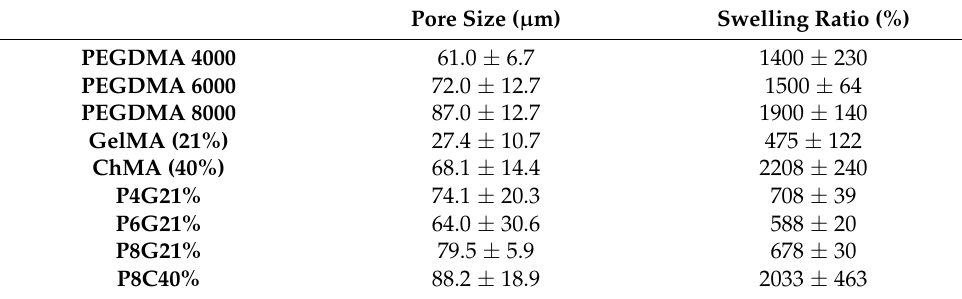
Table 2. Comparison of morphology and swelling behavior for DN hydrogels.